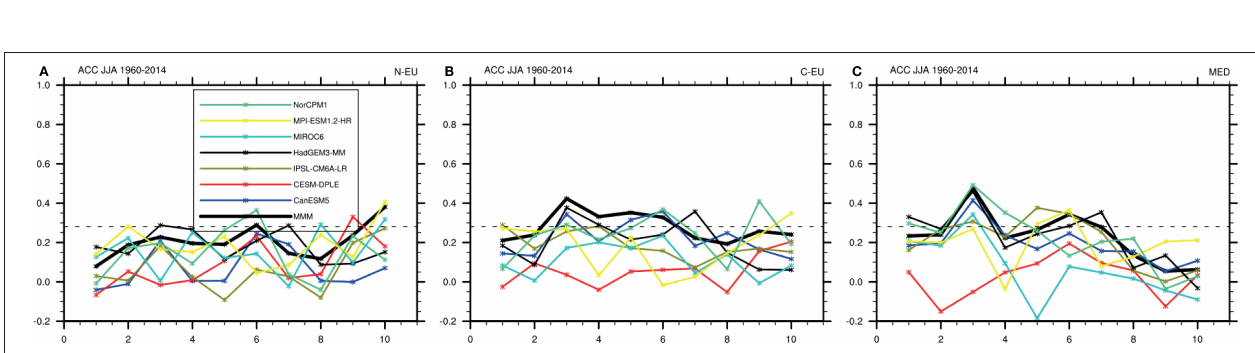
FIGURE 10 | ACC of detrended summer (JJA) SAT in the SREX regions (A) Northern Europe, (B) Central Europe, and (C) Mediterranean (y-axis) against lead time in years (x-axis). The horizontal dashed line represents the 95% confidence level compared to climatological prediction based on a two-sided t